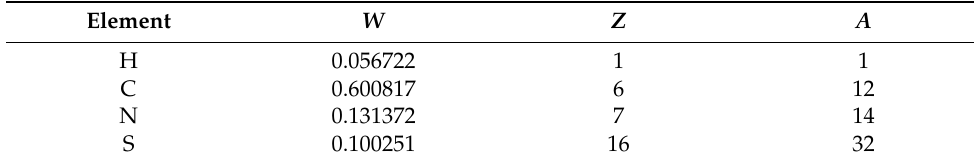
Table 1. Weight proportion values, atomic number and atomic weight for each constituent element of MB ion calculated using XCOM software. Element W Z A